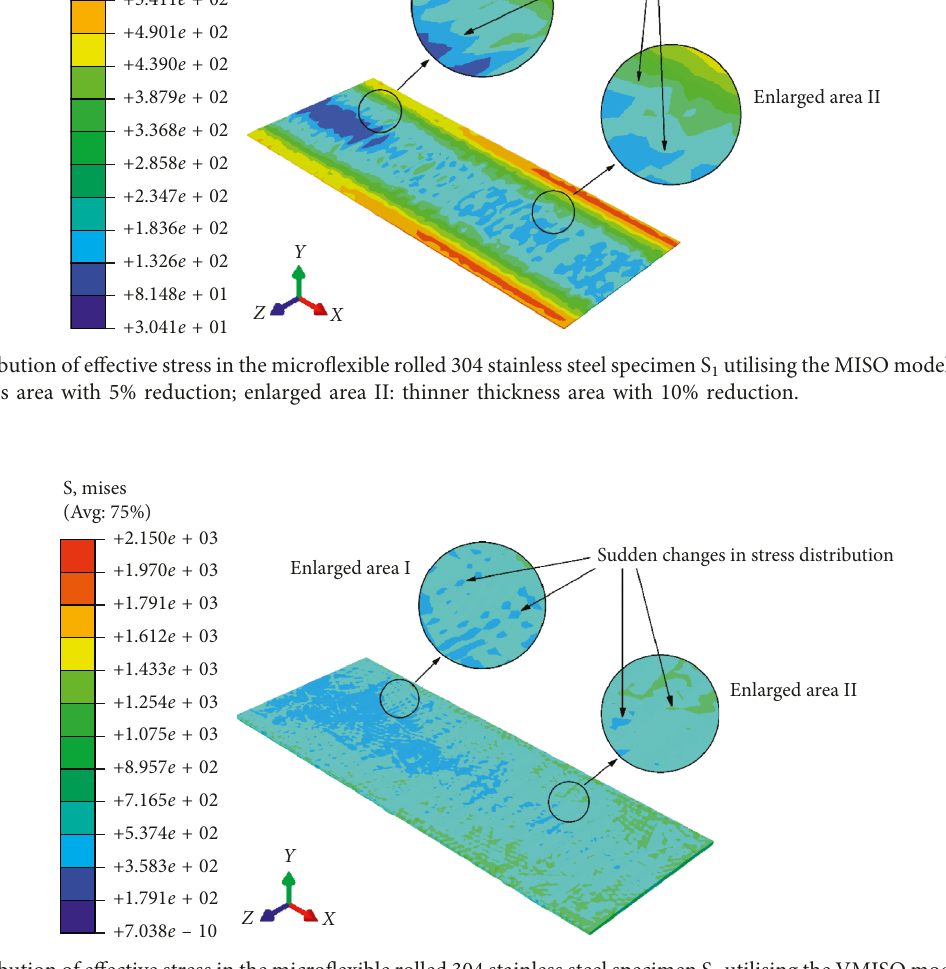
1 utilising the VMISO model. Enlarged area